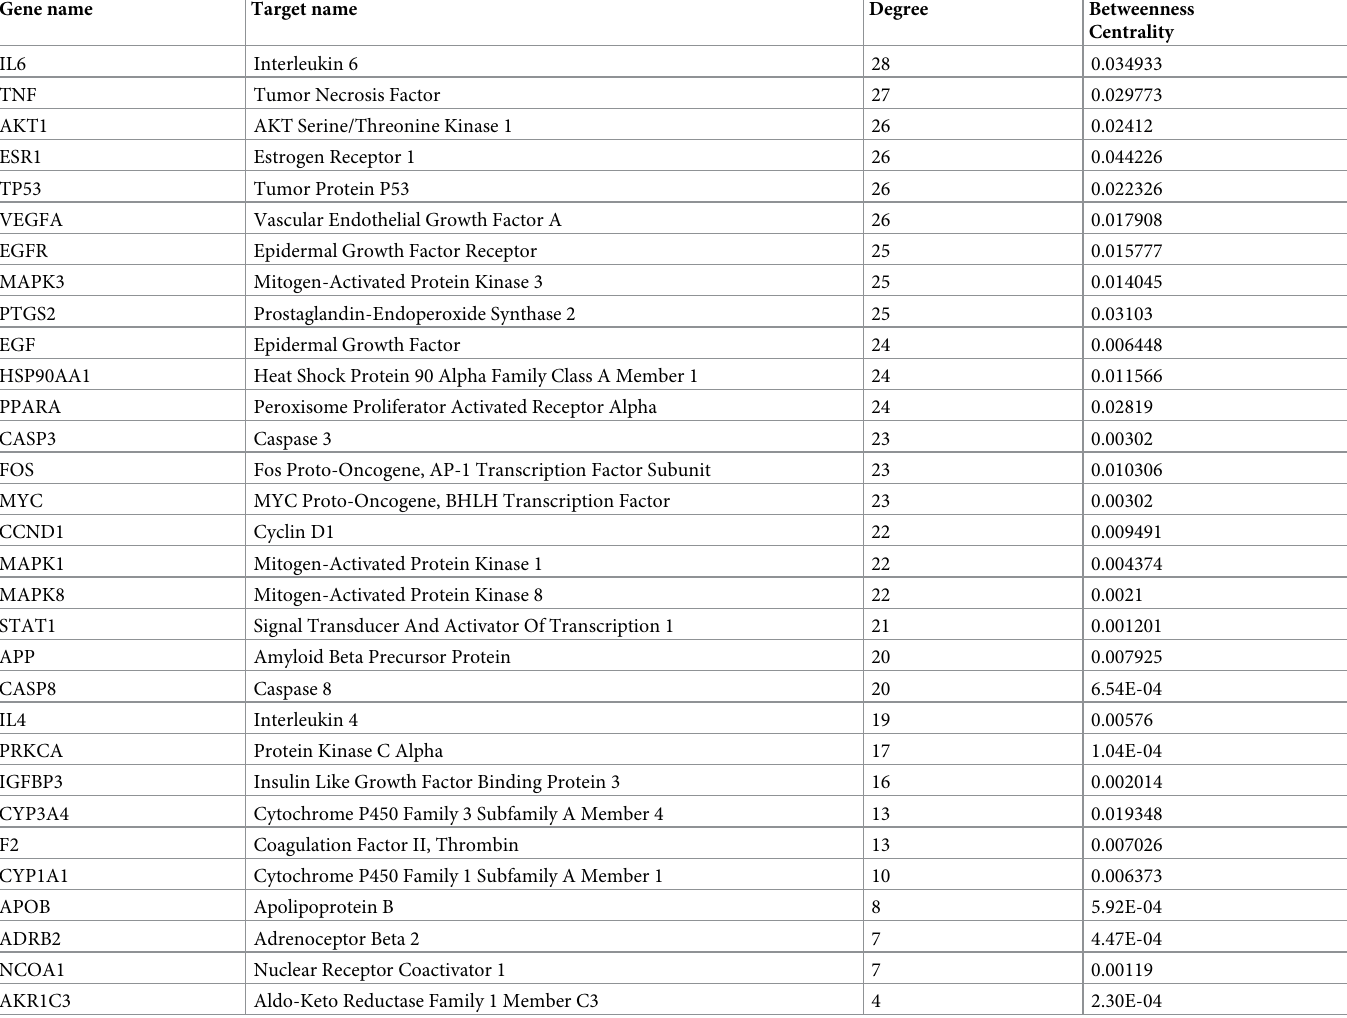
Table 3. Degrees and betweenness centralities of the 31 key target genes targeted by EH-CS as predicted by the PPI network